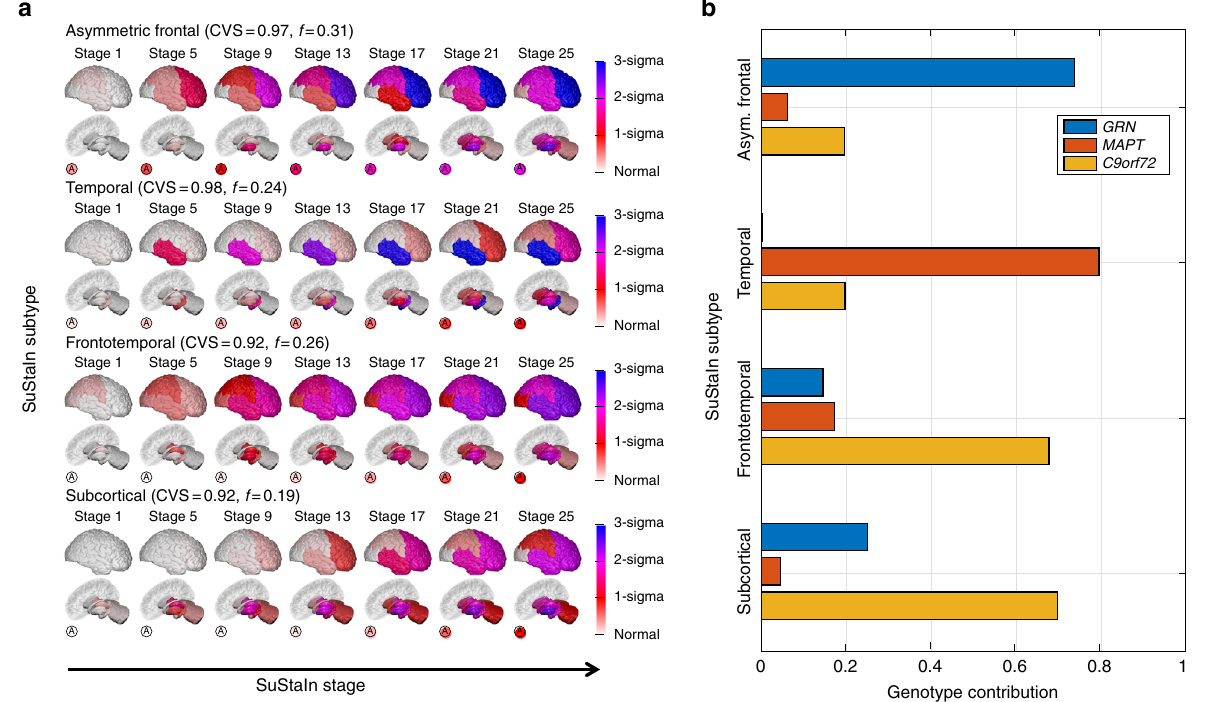
Fig. 2 SuStaIn modelling of genetic frontotemporal dementia using GENFI data. a The progression pattern of each of four subtypes that SuStaIn identi fi es. Each progression pattern consists of a sequence of stages in which regional brain volumes in mutation carriers (symptomatic and presymptomatic) reach different z -scores relative to non-carriers. Intuitively (for a more precise description see Methods: Uncertainty Estimation), at each stage the colour in each region indicates the level of severity of volume loss: white is unaffected; red is mildly affected ( z -score of 1); magenta is moderately affected ( z -score of 2); and blue is severely affected ( z -score of 3 or more). The circle labelled A indicates the asymmetry of the atrophy pattern (absolute value of the difference in volume between the left and right hemispheres divided by the total volume of the left and right hemispheres) at each stage for each subtype. CVS is the model cross-validation similarity (see Methods: Similarity between two progression patterns): the average similarity of the subtype progression patterns across cross-validation folds, which ranges from 0 (no similarity) to 1 (maximum similarity). f is the proportion of participants estimated to belong to each subtype. b The contribution of each genotype to each of the SuStaIn subtypes. This is calculated as the probability an individual has a particular